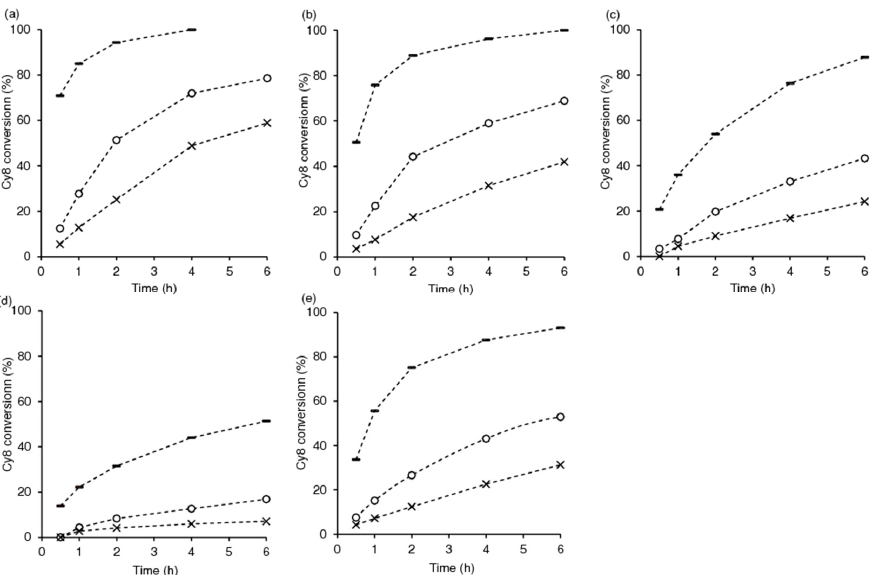
Figure 14. Consecutive batch runs (run 1 (-); run 2 (o); run 3 (×)) of Cy8/TBHP in the presence of ( a ) Mo-TUD(IWI-acac), ( b ) Mo-TUD(IWI-amm), ( c ) Mo-TUD(IWI-ahm), ( d ) Mo-TUD(HT) or ( e ) Mo-hierBEA, at 70 °C. Epoxide selectivity was always 100%.